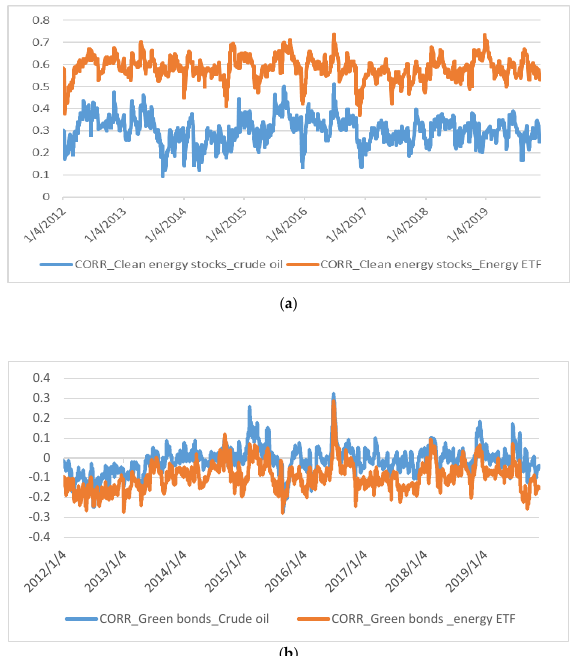
Figure 1. ( a )Time-varying condition correlation between clean energy stocks and each of the two dirty indices. Source: Authors’ calculation. ( b ) Time-varying condition correlation between green bonds and each of the two dirty indices. Source: Authors’ calculation. Energies 2020 , 12 , x FOR PEER REVIEW